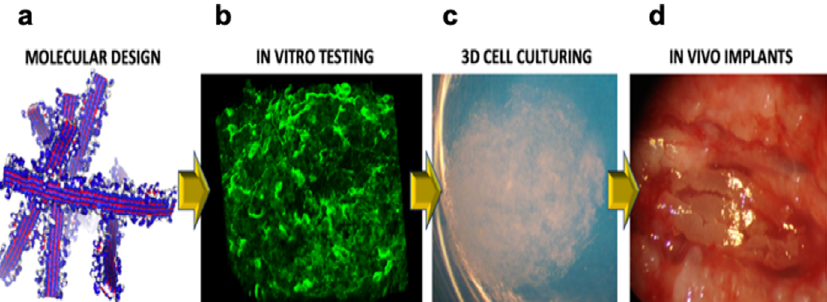
Fig. 2 The assembly line of self-assembling peptides toward clinics. a Molecular modeling for both all-atom and coarse-grained simulations of self-assembling peptides featuring different functionalizations are necessary to verify the self-assembling propensity and solubility of new sequences 24 . b Nano fi bers of self-assembling peptides scaffold hydrogels are subsequently tested with cells (either to be transplanted or from the target tissue) in vitro to verify cytotoxicity and biomimetic properties of the novel construct. c Synthetic self-assembling peptides are tailored into 3D constructs with densely seeded cells (image courtesy of Amanda Marchini), potentially leading to organoids in long-term cultures in serum-free conditions. d Selected self-assembling hydrogels (seeded with cells or loaded with drugs) are injected or positioned (after self-assembling) in in vivo animal models of the target pathology. All steps provide essential data for subsequent clinical